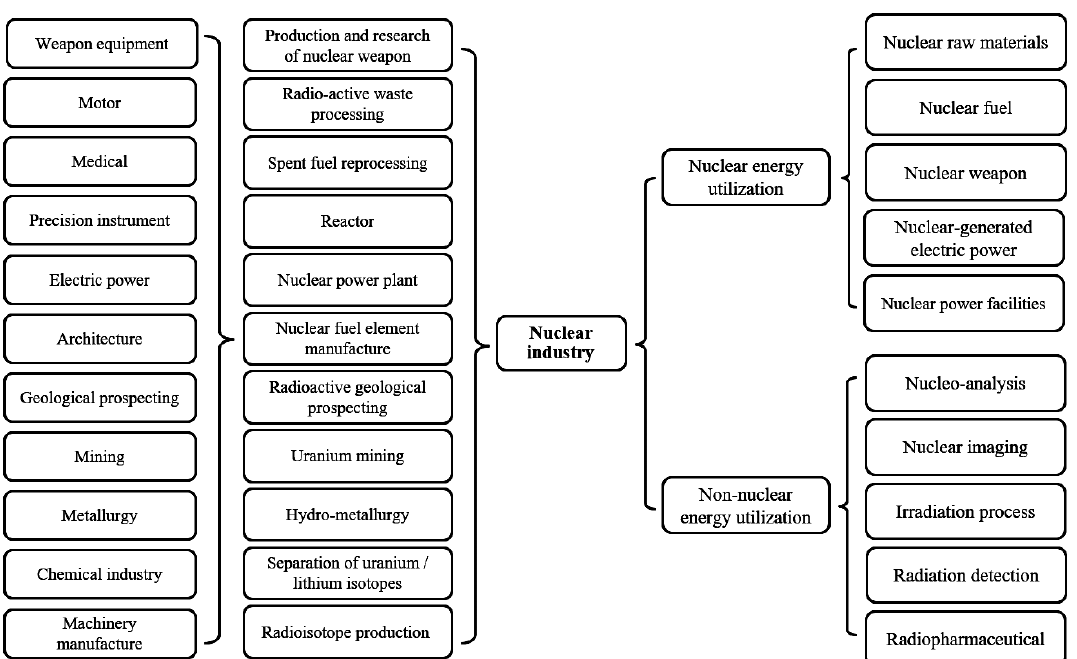
Fig. 1 Common application fields of the nuclear industry. The first column on the left represents the weapon equipment, motor, medical, chemical industry, and other disciplines involved in the nuclear industry. The second column on the left lists the manufacturers, as well as the Research and Development (R&D) institutions related to the nuclear industry. On the right side of the figure, nuclear industrial applications are divided into nuclear energy utilization and non-nuclear energy utilization. Among them, nuclear power converts nuclear energy into electric energy by controllable nuclear reaction belonging to nuclear energy utilization, and nuclear medical belongs to non-nuclear energy